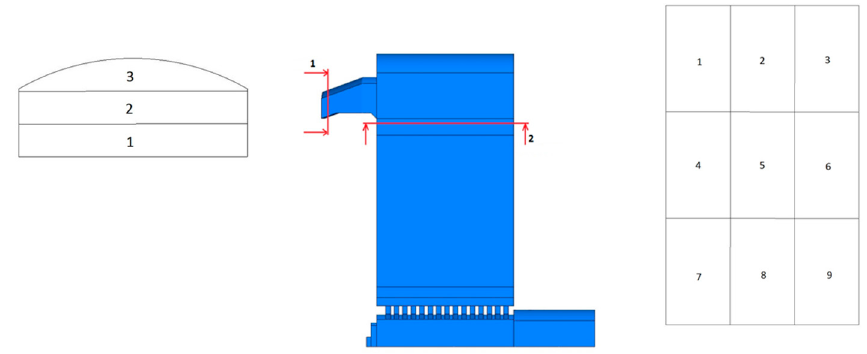
Figure 6. Control sections and experimental grid.